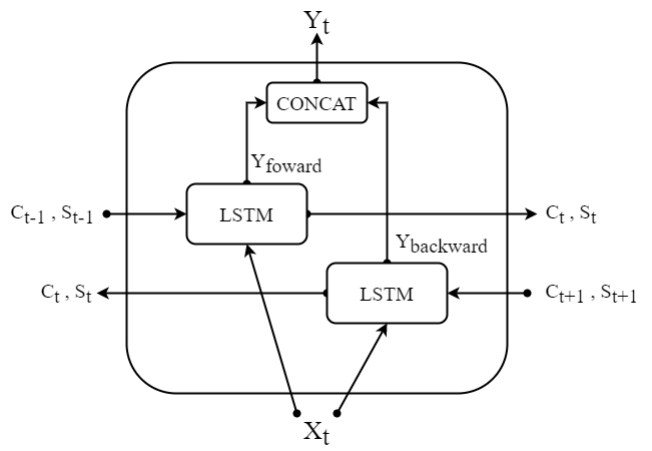
Figure 4. Illustration of the architecture of Bidirectional Long Short-Term